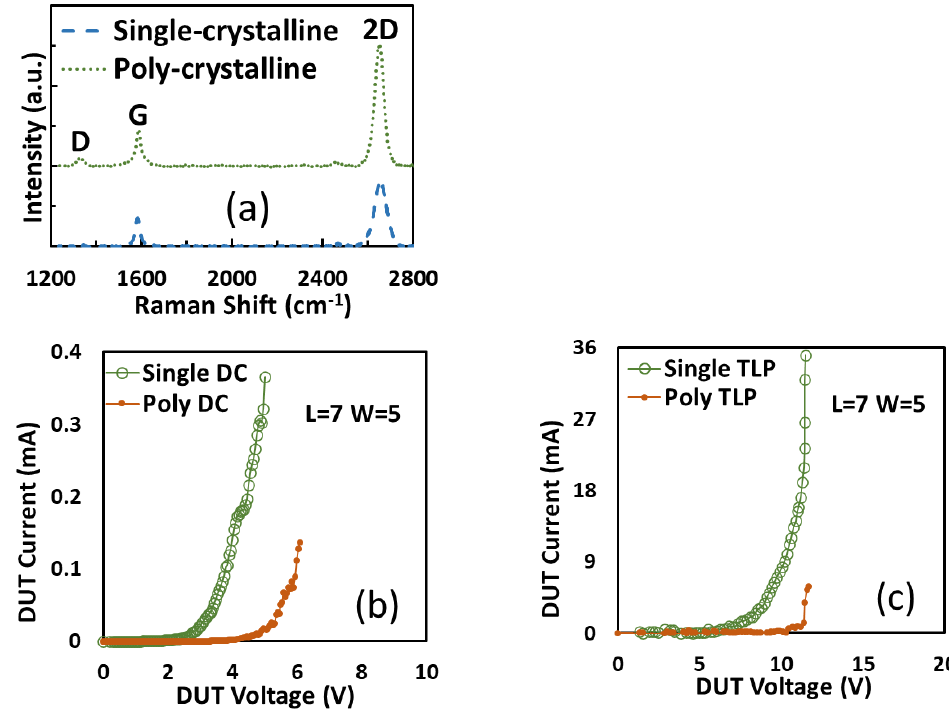
Figure 21. Measurement comparison of gNEMS devices made in single-crystal and polycrystal graphene films: ( a ) Raman spectrum, ( b ) DC sweeping test, and ( c ) TLP test [44].